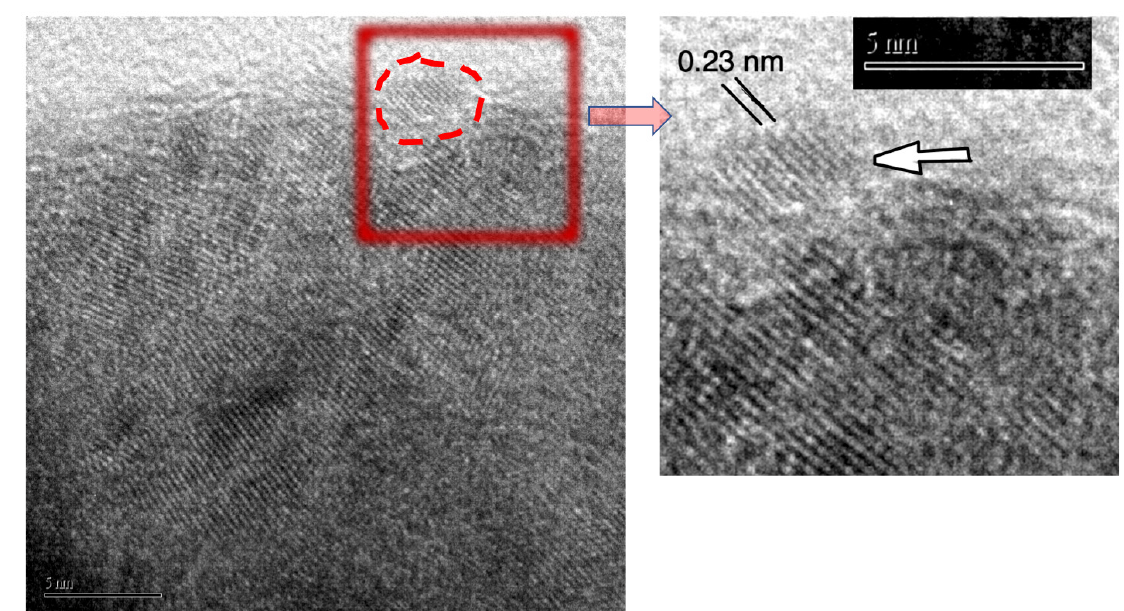
Figure 7. High-resolution TEM image. The images show nanoparticles as small as about 3 nm taken near the surface of an agglomerate. The measured distance between plains is compatible with the distance of (1,0,2) planes of hexagonal ZnS (i.e., about 0.23 nm) .